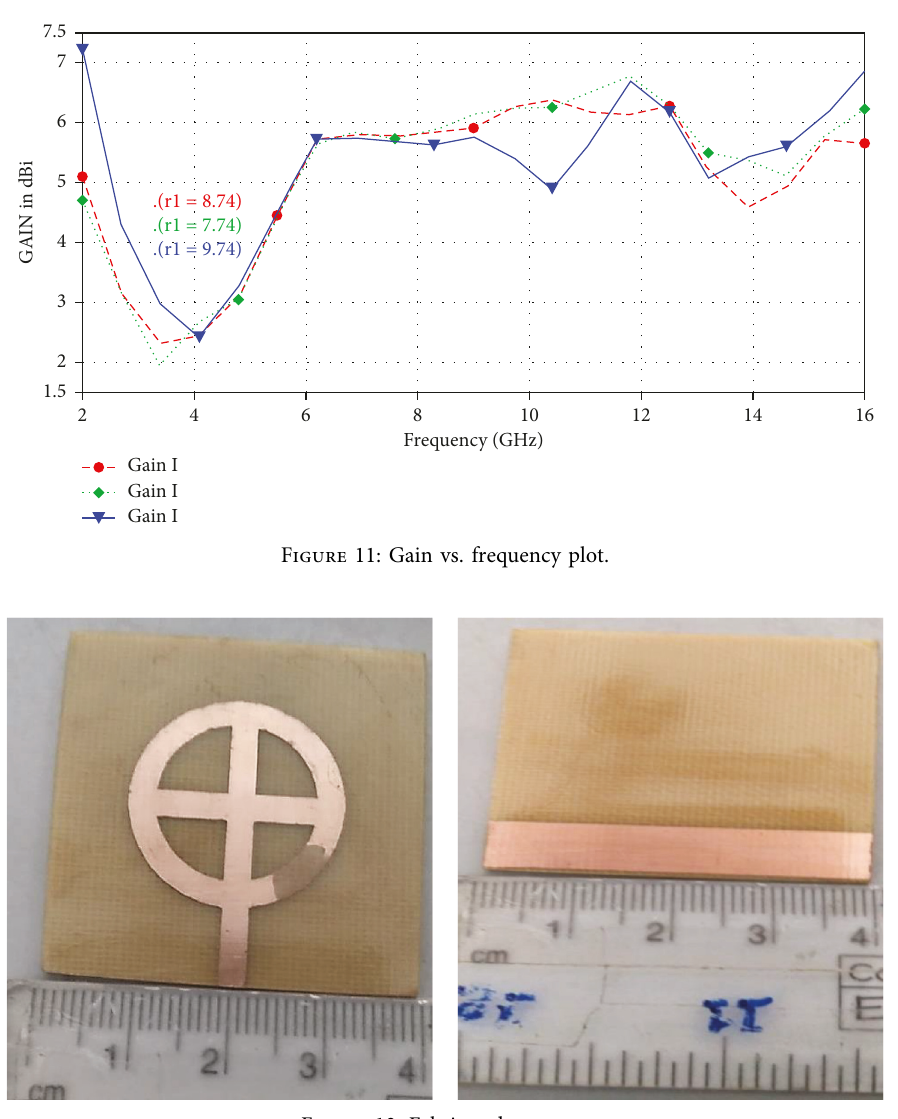
Figure 12: Fabricated antenna.